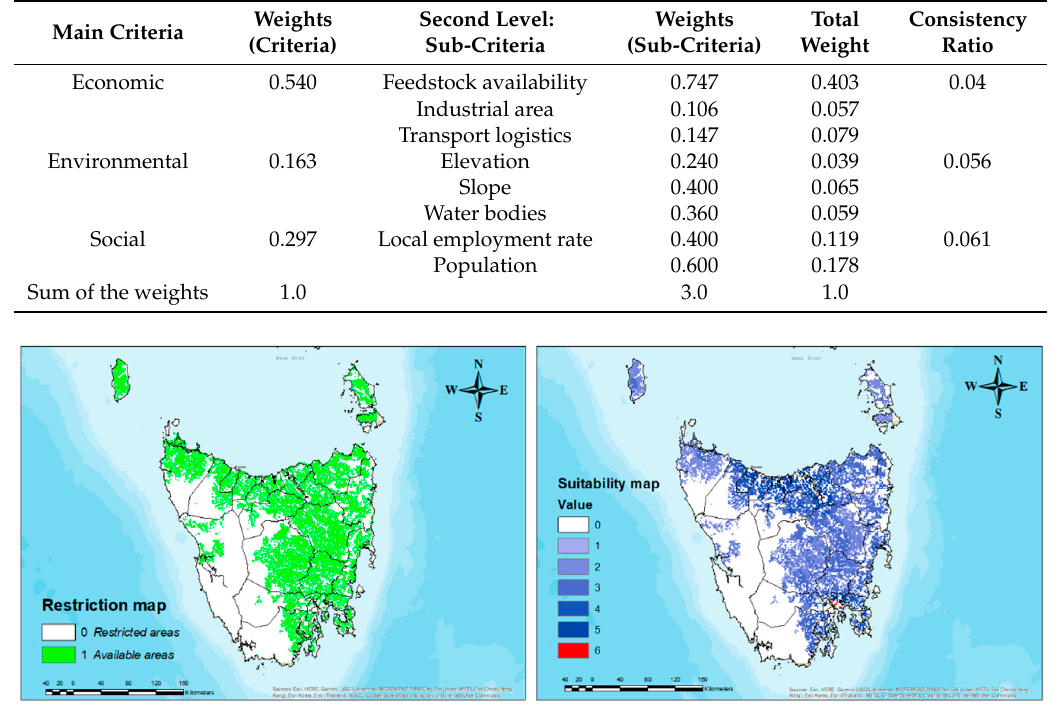
Figure 4. Map of restricted and available areas, and suitability map for bioenergy plant locations in Tasmania.